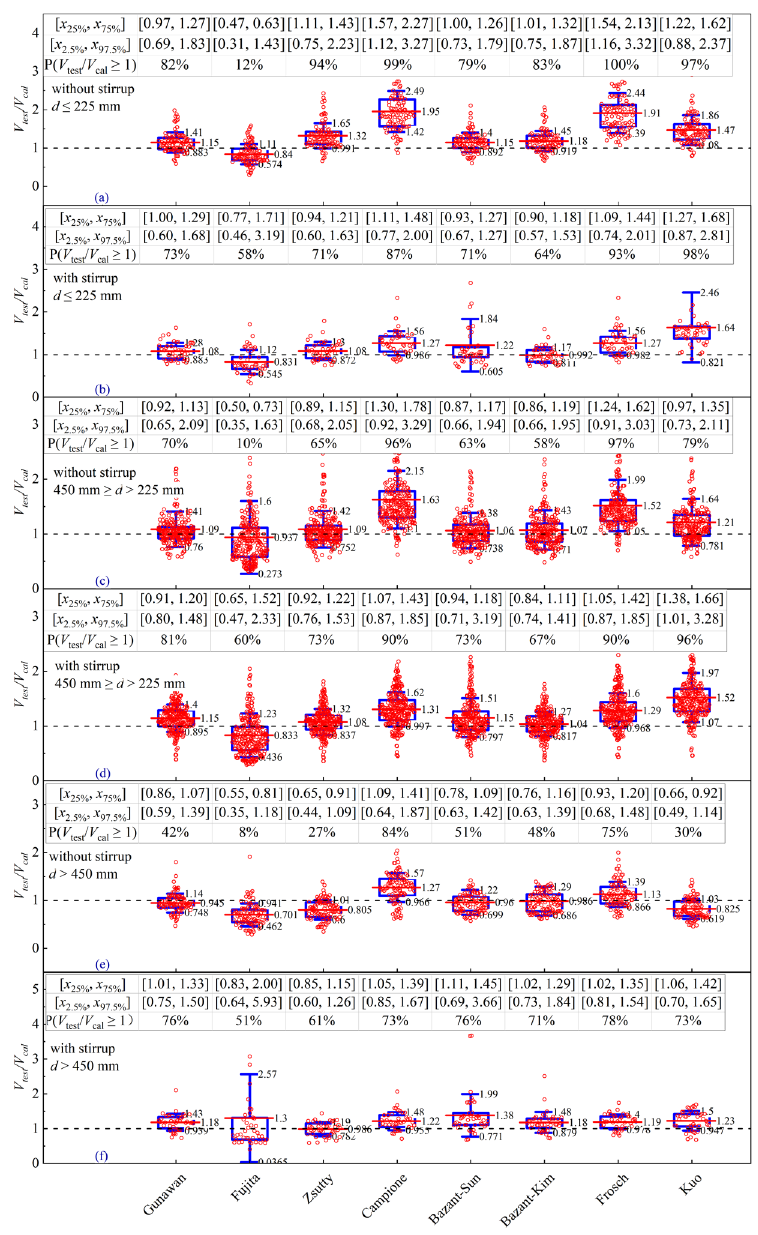
Figure 11. Researchers: prediction results for beams without stirrup versus ( a ) d ≤ 225 mm; ( c ) 225 mm < d ≤ 450 mm; ( e ) d > 450 mm and for beams with stirrup versus ( b ) d ≤ 225 mm; ( d ) 225 mm < d ≤ 450 mm; ( f ) d > 450 mm .